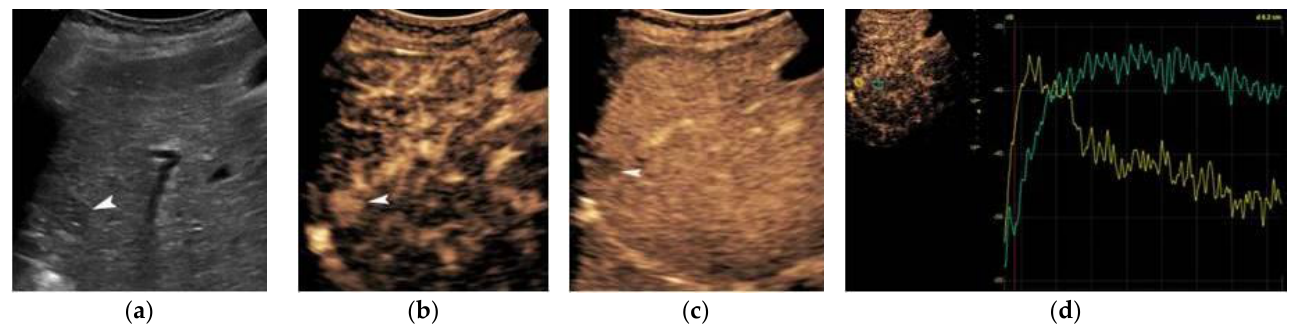
Figure 1. Typical CEUS findings of HCC nodule. B-mode ( a ) showing a hypo-echoic nodule (arrowhead) inside a heterogeneous cirrhotic liver. Arterial ( b ) and portal-venous phase ( c ) CEUS image showing homogeneous arterial phase hyperenhancement and mild wash-out, respectively, in keeping with HCC (arrowhead). Time-Intensity-Curve analysis ( d ) confirming the earlier enhancement of the nodule on arterial phase and wash-out. Quantitative parameters can be extracted using this type of analysis.